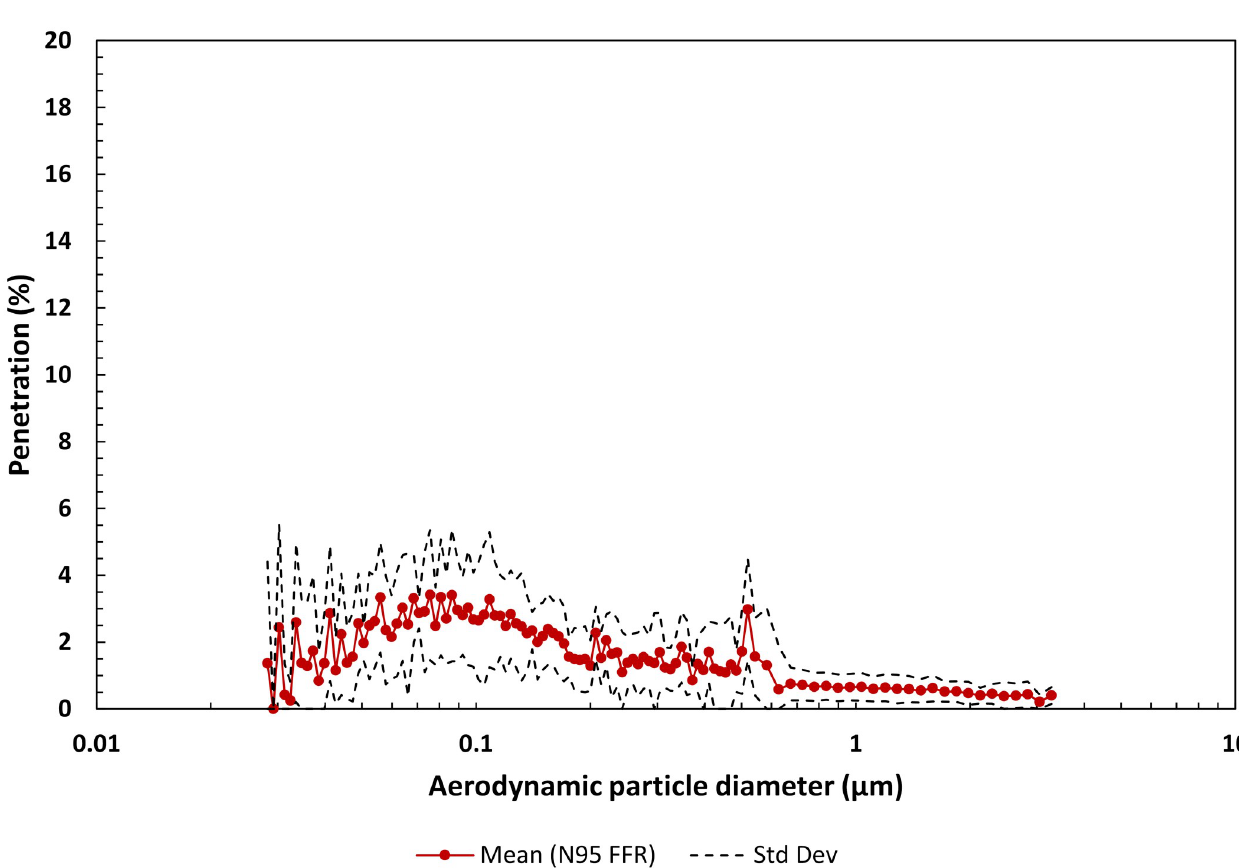
Fig 8. Mean penetration profile as a function of aerodynamic particle diameter for the filter material of five N95 FFRs (three replicates each). Note, the penetration range is 0 to